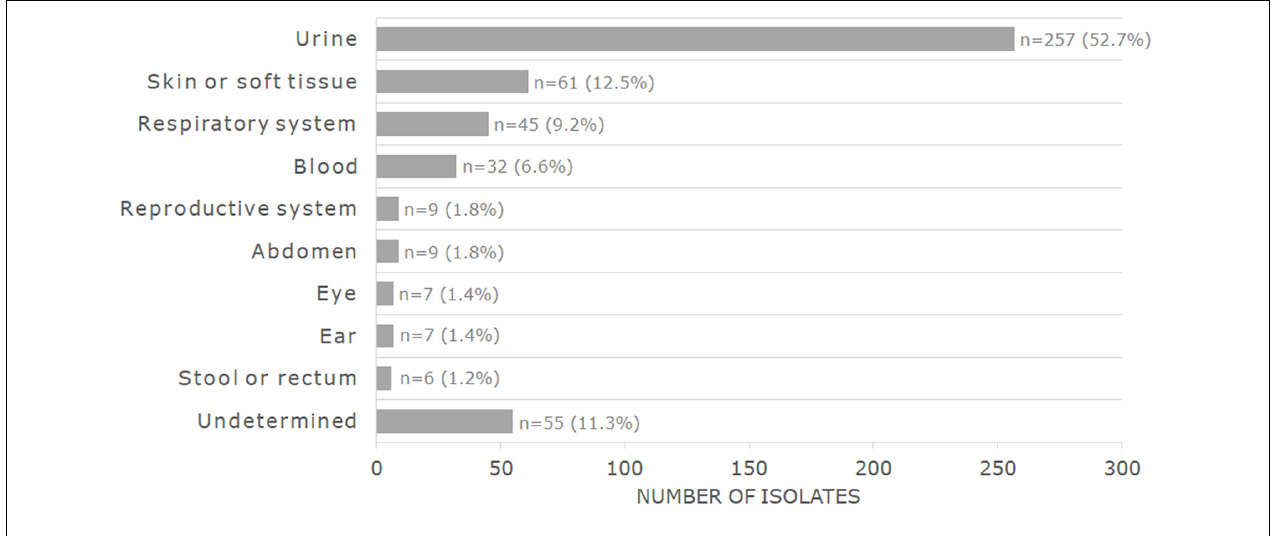
FIGURE 1 | Distribution by sample source of the 488 bacterial isolates analyzed in this study.